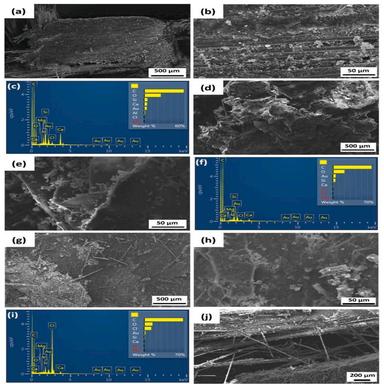
SEM images and EDX spectra of RCWTB: (a–c) fibers; (d–f) balsa wood; (g–i) polyurethane; (j) micro-fibers.